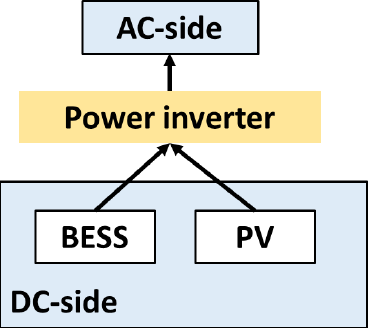
Figure 16. The simplified framework of power flow in the hybrid microgrid.